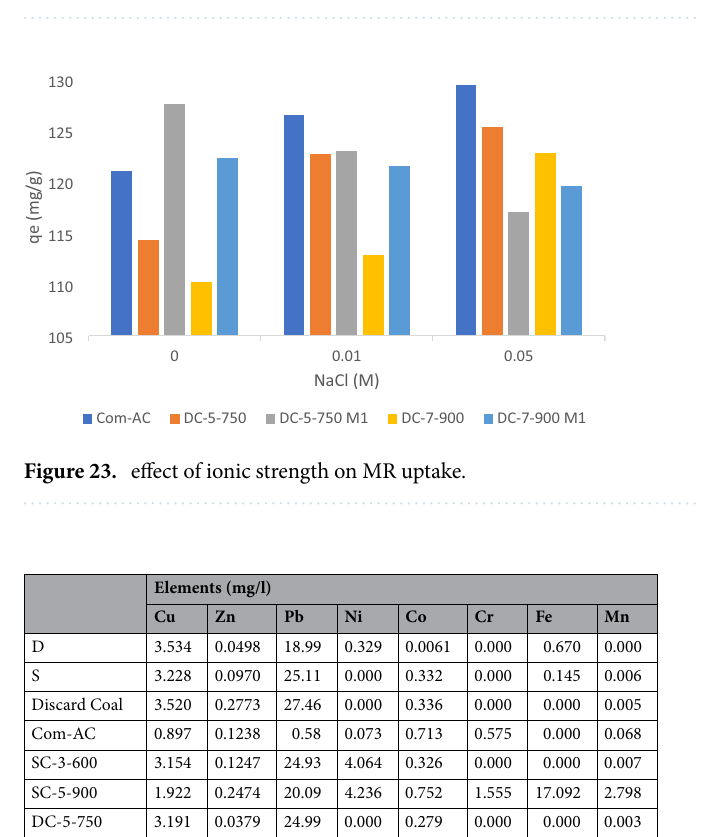
Table 12. Comparison of nitrate Langmuir maximum capacity with literature. AC * Activated carbon, CETAB cetyl trimethyl ammonium bromide.